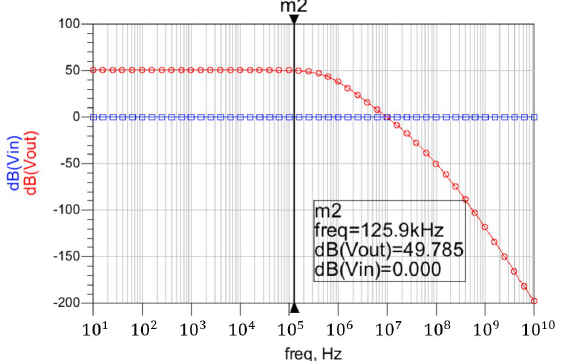
Figure 5. Simulation results of the pre-amplifier and the filter.